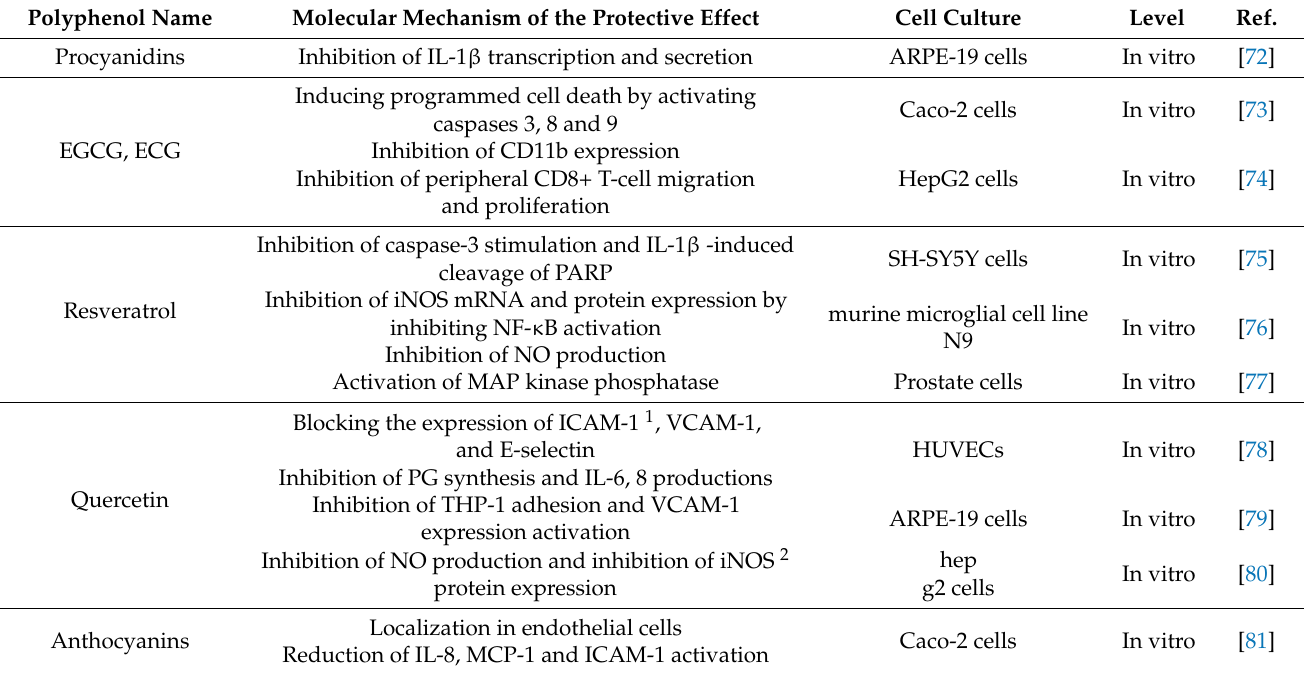
Table 8. Anti-inflammatory effects of the polyphenol content of grape marc (grape seeds and